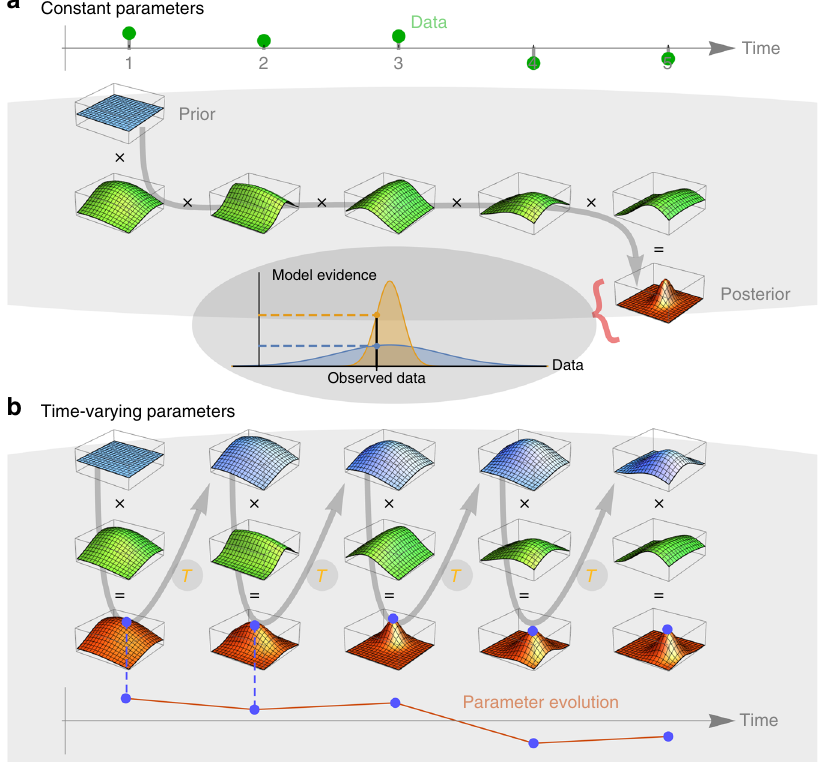
Fig. 1 Bayesian updating and Occam ’ s razor. a For a model with constant parameters, the multiplication of the prior distribution (blue) with all factors of the likelihood function (green; one factor for each new data point) directly yields the unnormalized posterior distribution (red). The normalization constant of the posterior distribution represents the model evidence. Here, restrictive models (inset, yellow) concentrate their evidence on a smaller subset of possible datasets compared to more fl exible models (inset, blue) and thus attain a higher model evidence, if both models fi t the data equally well. b For a model with time-dependent parameters, the multiplication of the prior distribution (blue) and the likelihood function (green) is carried out for each time step individually. Between time steps, the posterior distribution (red) is transformed according to a high-level model T , to re fl ect possible changes of the